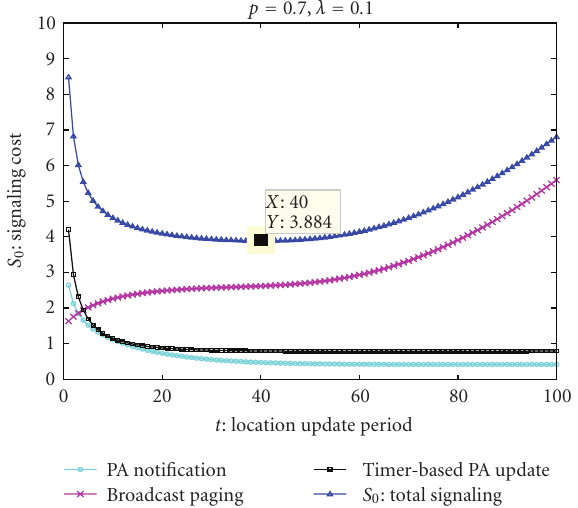
Figure 14: Signaling cost: high mobility and high message arrival rate.